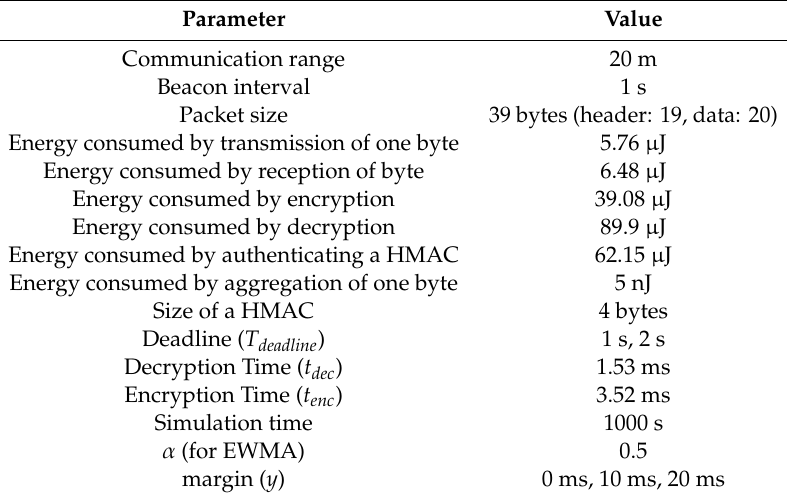
Table 1. Parameter values used in the